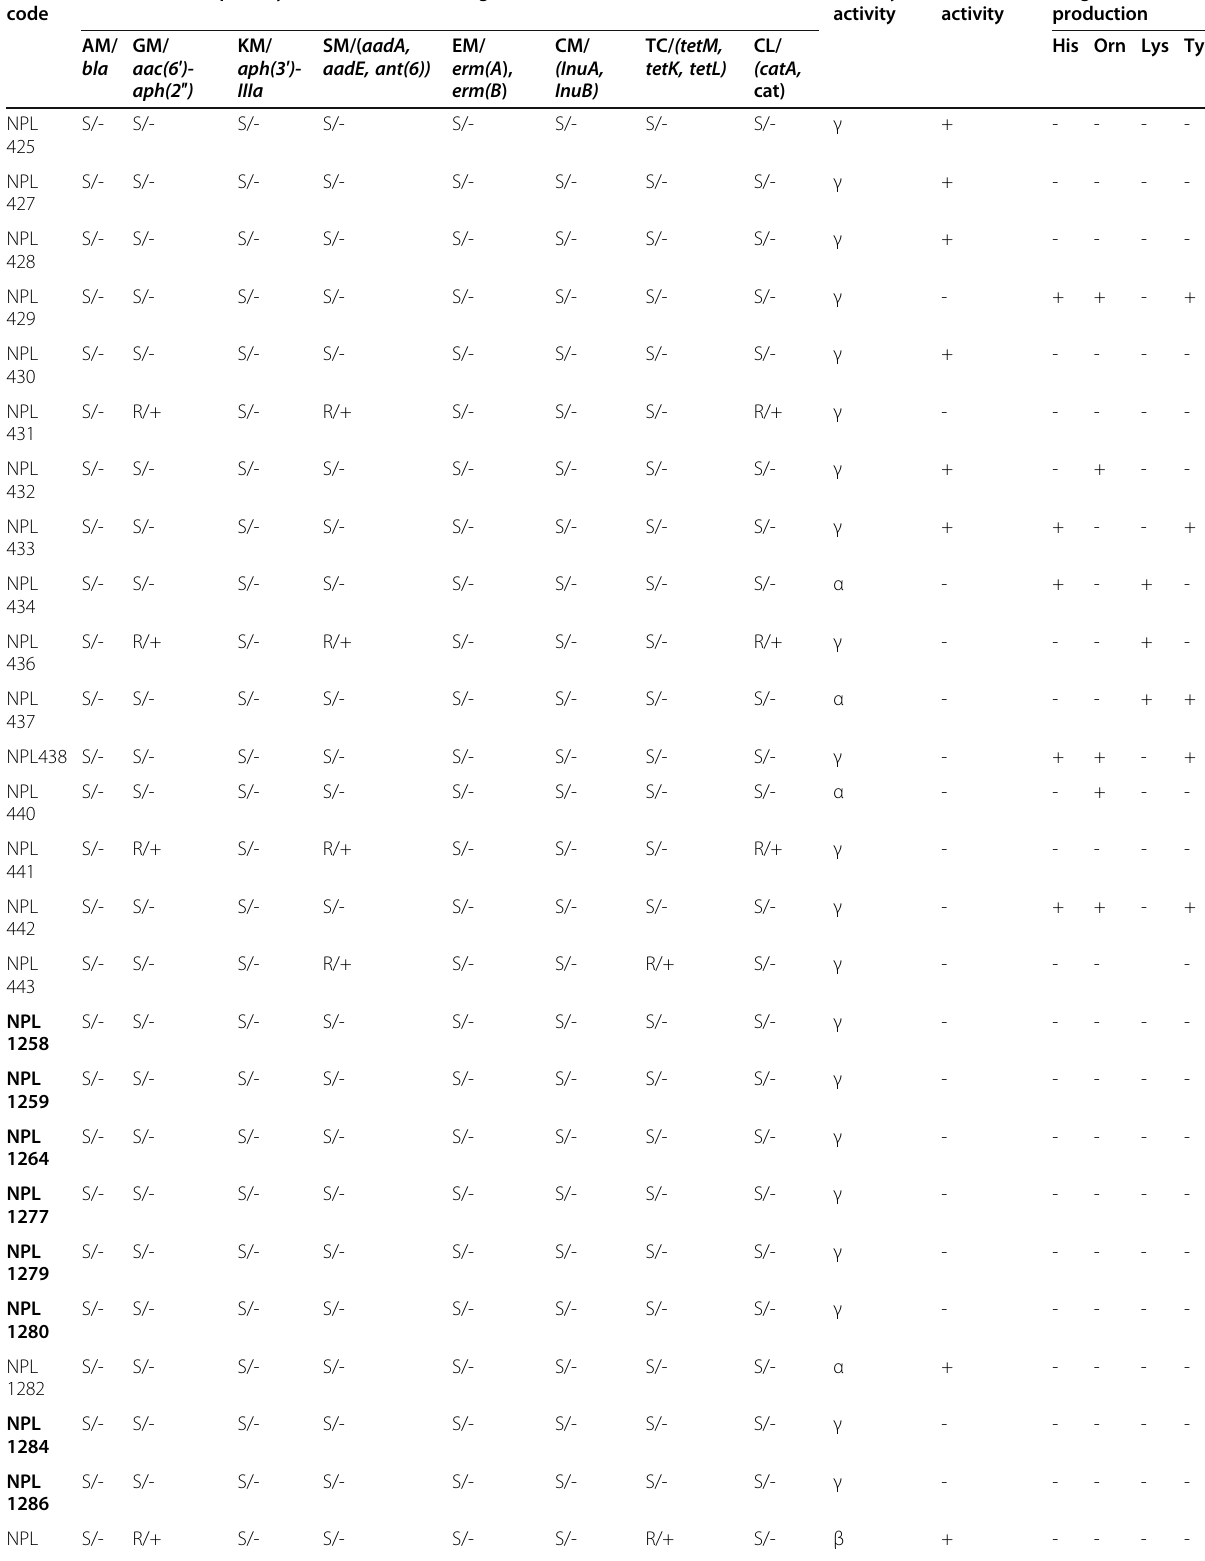
Table 2 Safety assessment of the LAB strains Strain